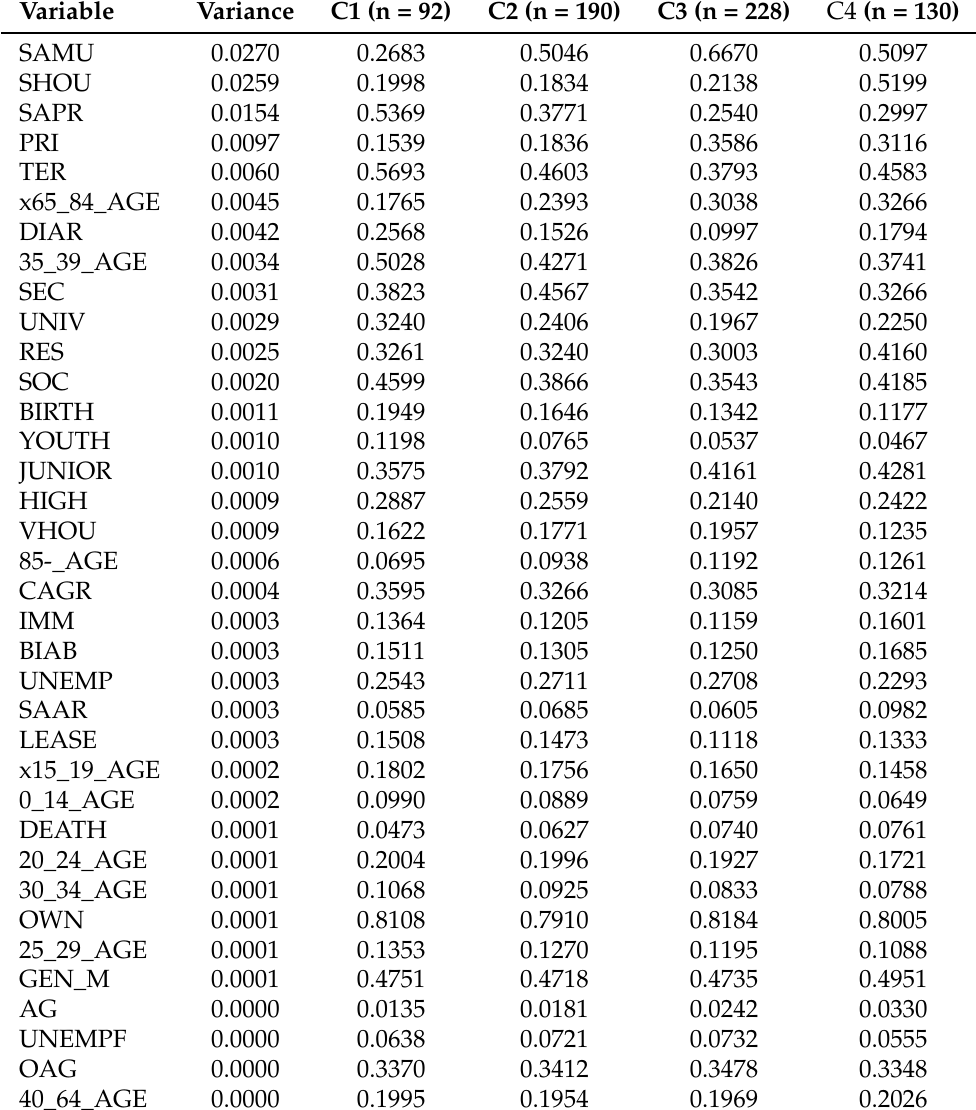
Table 2. Variable weight means in the output nodes, ordered by variance